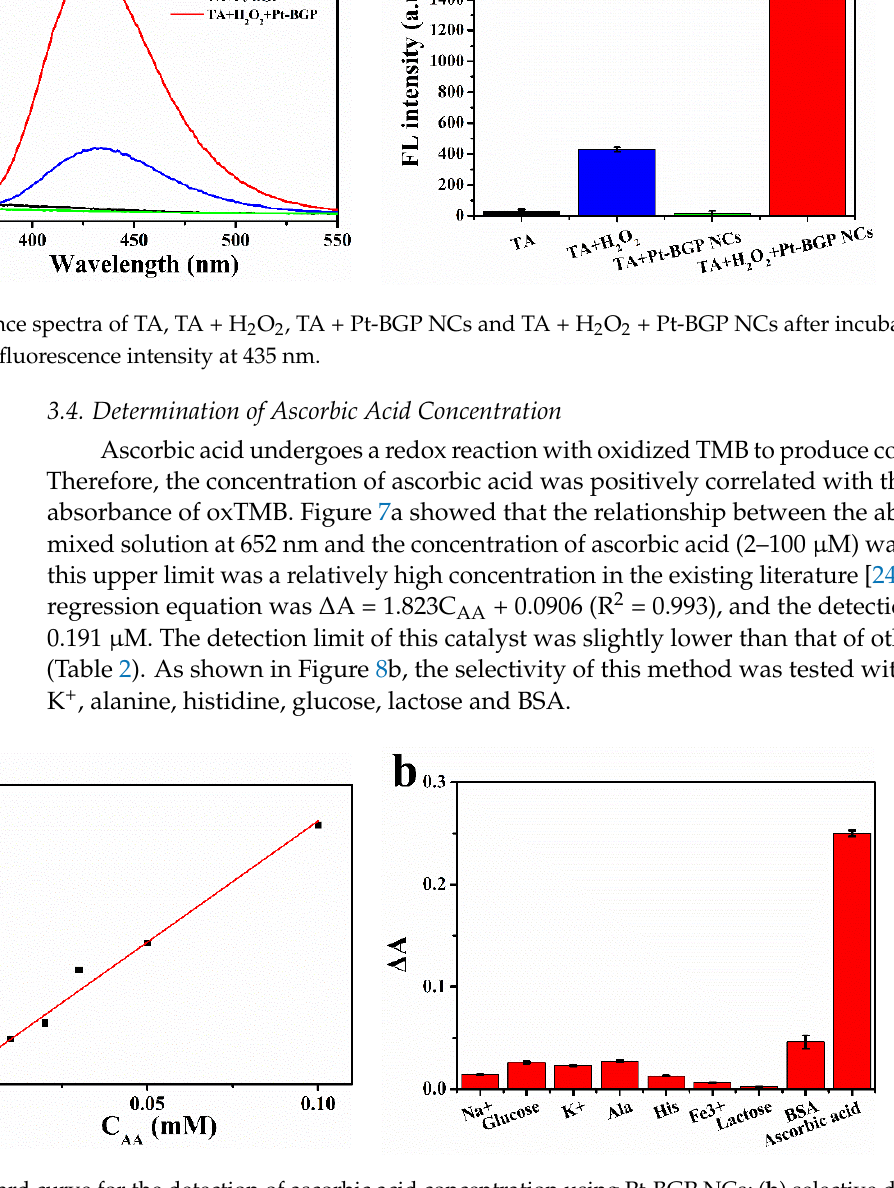
Figure 7. ( a ) The standard curve for the detection of ascorbic acid concentration using Pt-BGP NCs; ( b ) selective detection of ascorbic acid. Table 2. Comparison of linear range and detection limit of different peroxidase mimics.